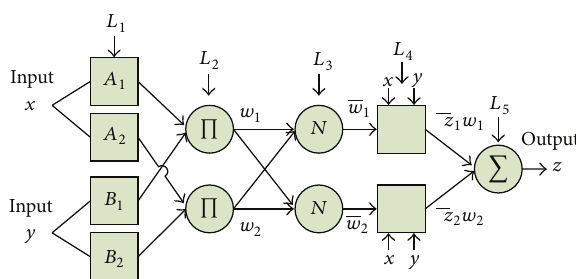
Figure 2: Adaptive network-based Fuzzy Inference System scheme with two inputs, four membership functions, two rules, and one single